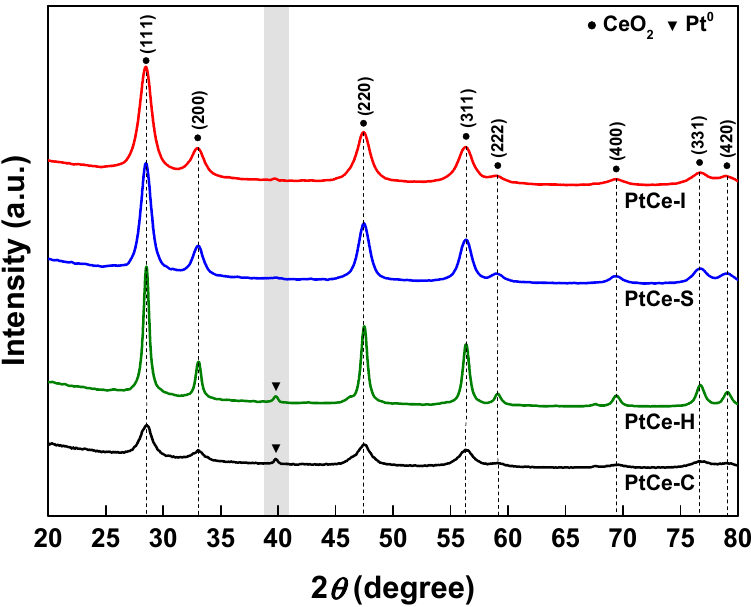
Figure 1. XRD patterns of reduced CeO 2 -supported Pt catalysts prepared by various synthesis meth ‐ ods.